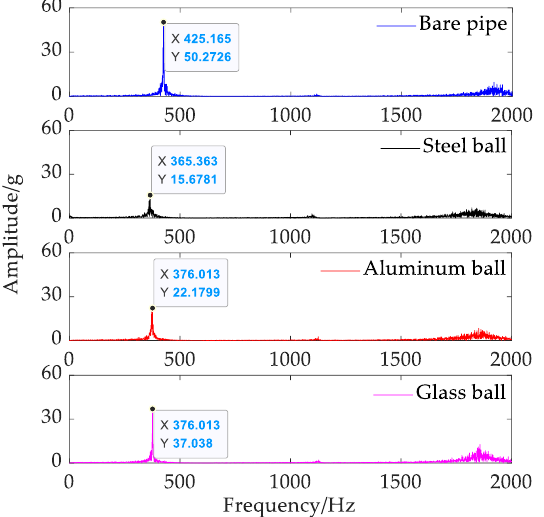
Figure 9. Spectral responses of damped pipeline with different materials at a 20% filling rate.